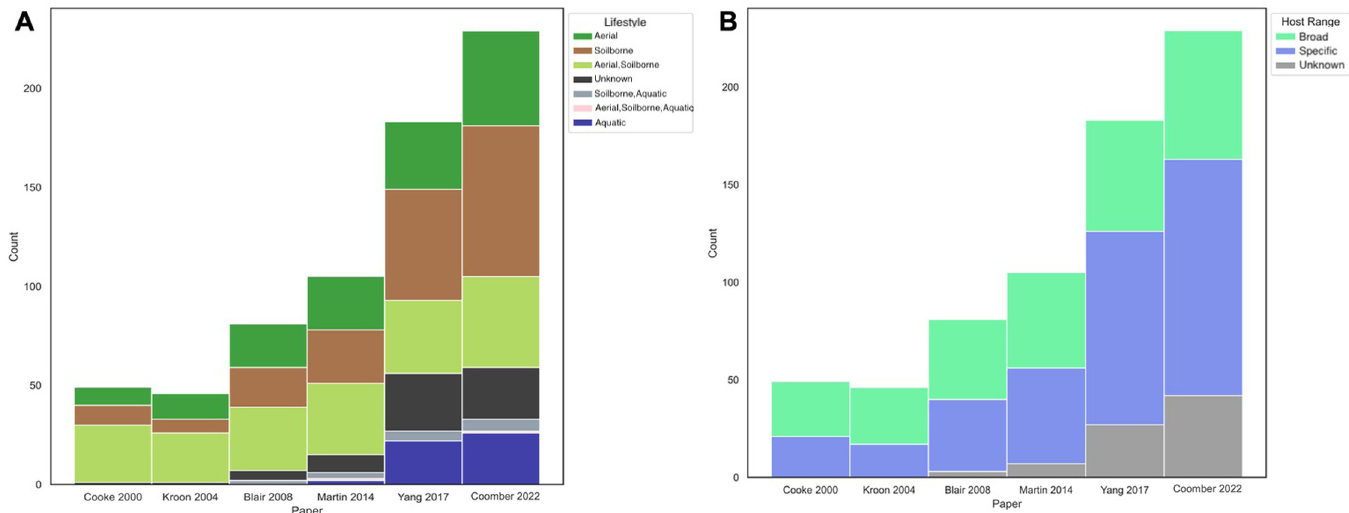
Fig 5. (A) Histogram of Phytophthora species in each lifestyle category over time. Histogram showing the number of Phytophthora species in each lifestyle category in major phylogenies published since 2000. (B) Histogram of Phytophthora species sorted by host ranges over time. Histogram showing the number of Phytophthora species in each host range category in major phylogenies published since 2000. Host specificity was characterized as “broad” or “specific”. Species with reported hosts in three or more plant families were characterized as "broad”, while species with reported hosts in two or fewer plant families were described as "specific”.